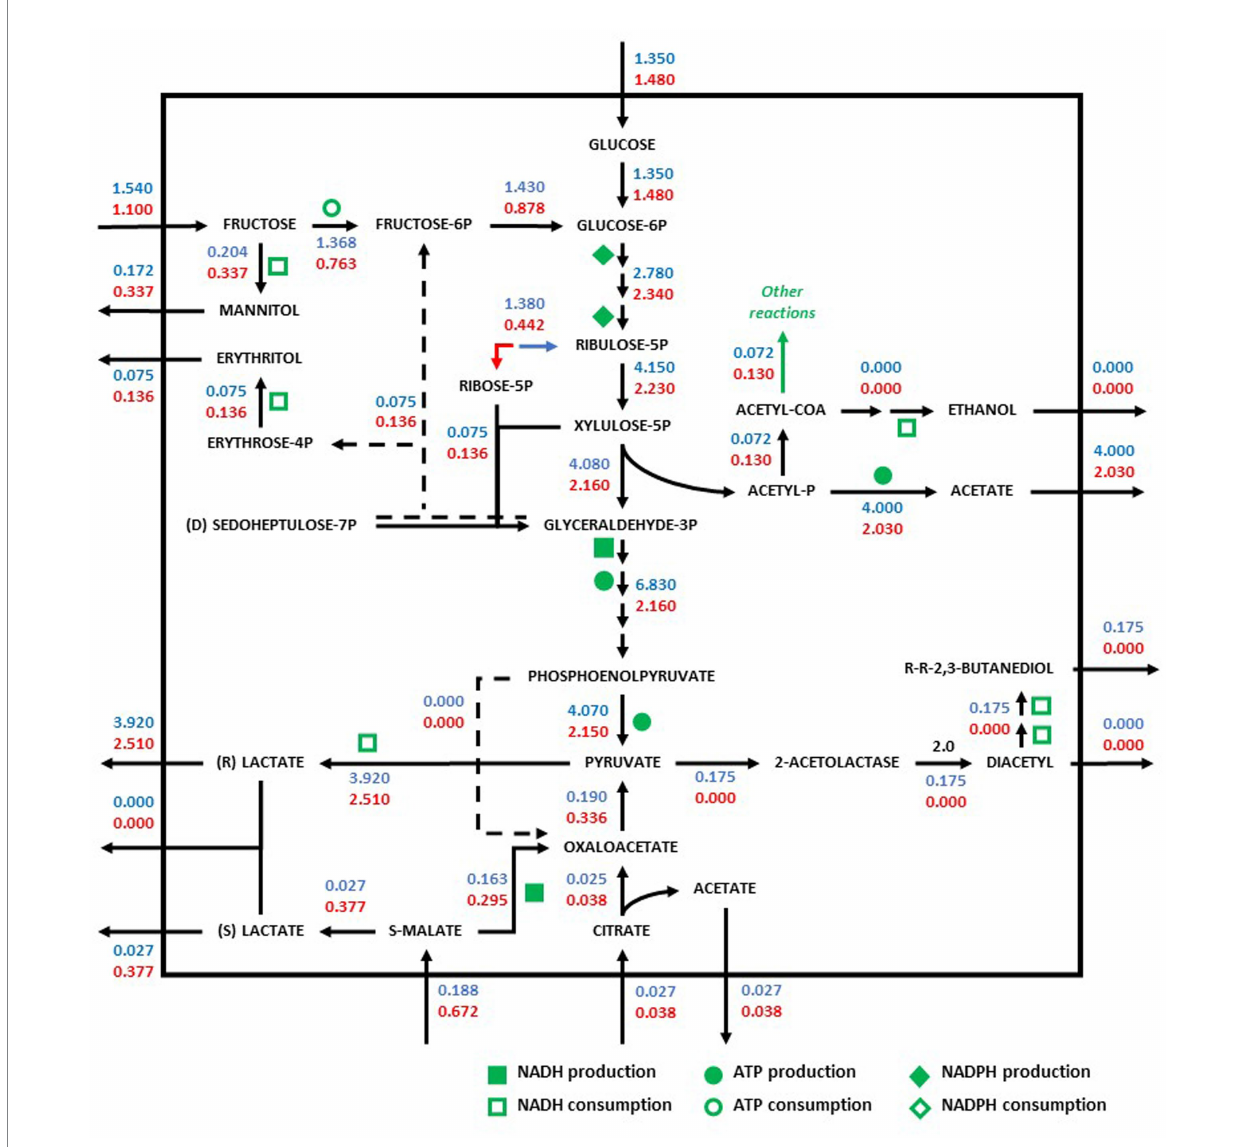
FIGURE 3 Redistribution of the metabolic flux of the strains Oenococcus oeni PSU-1 (blue) and O. oeni E1 (red) evaluated using MaxOeno. Square, circle, and diamond polygons indicate consumption (or production) of NADH, ATP, and NADPH, respectively. S-malate corresponds to L-malate. S-and R- lactate correspond to L-and D lactate,